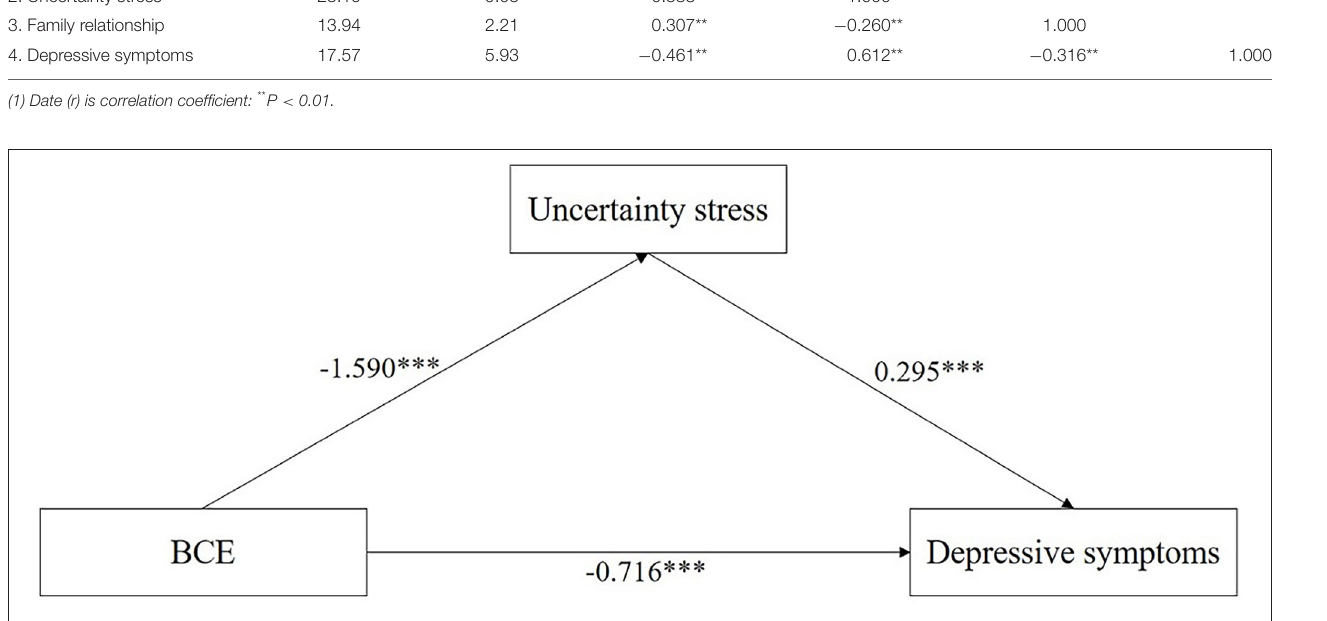
FIGURE 2 | Mediation modeling analysis of the relationship among BCE, uncertainty stress, and depressive symptoms. (1) Covariates controlled in the modeling analysis were Gender, Age, Grade, Only-child, Ethnicity, Residence, Parent’s marriage and education, Living expenses, Sexual orientation, Academic performance.